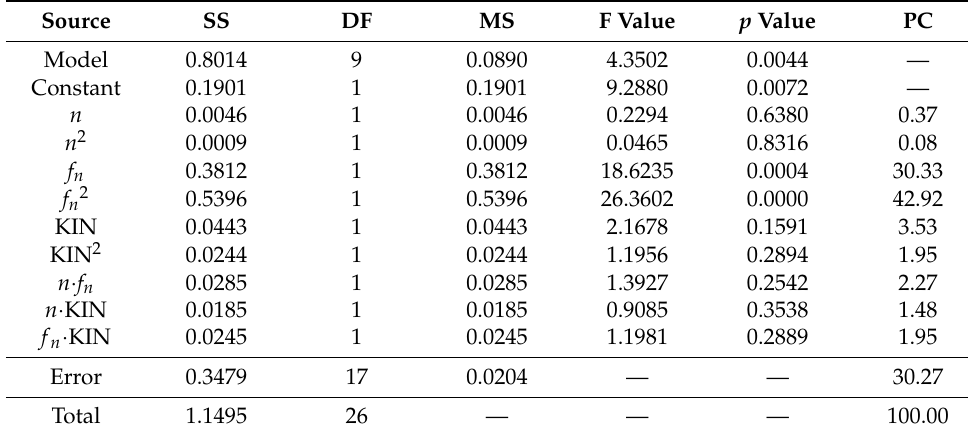
Table 9. ANOVA results for the parameter R a